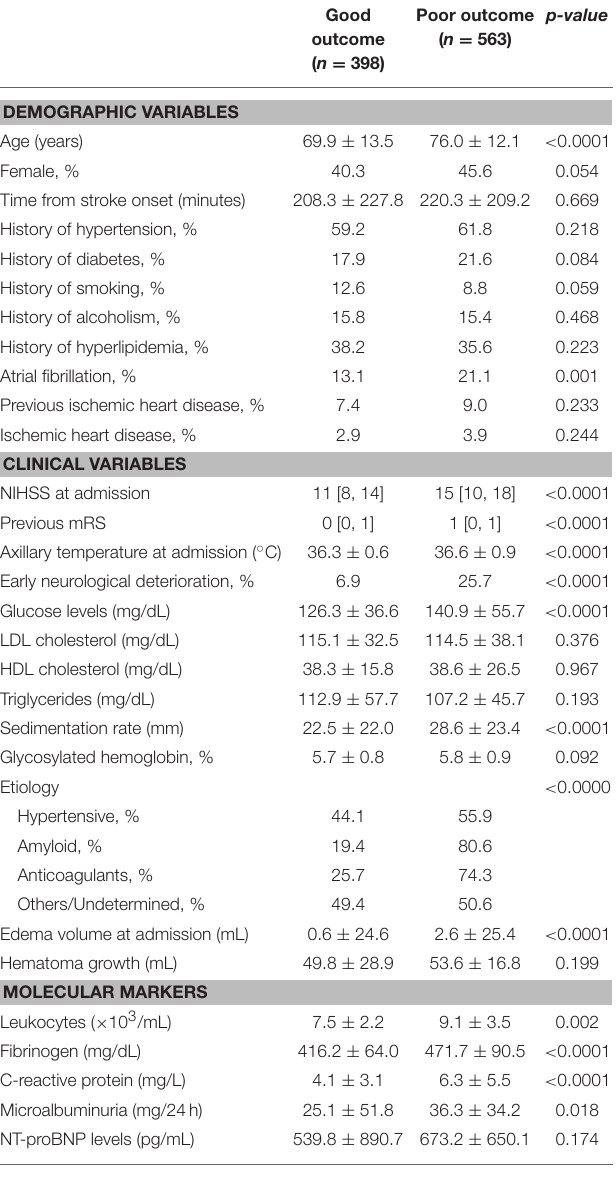
TABLE 5 | Baseline pre-hospital data, clinical characteristics and molecular markers findings in ICH patients with good or poor outcome at 3-months ( n =